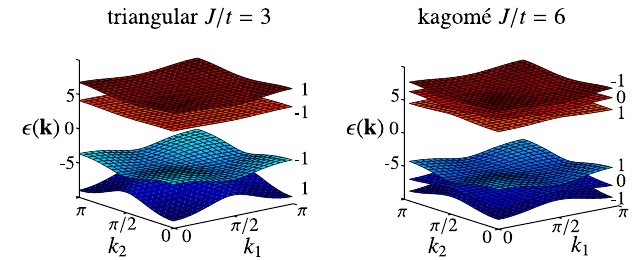
FIG. 3. The band structure of the Hamiltonian [Eq. (1)] for the triangular and kagome´ lattice models with textures as in Fig. 1. The Chern numbers of the individual bands are indicated to their right. Here, k ¼ k Q